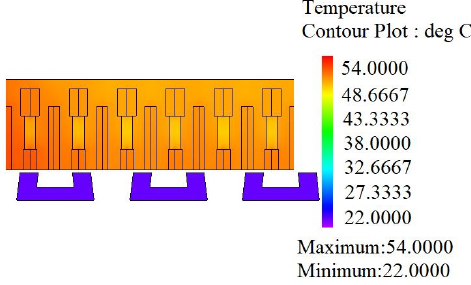
Figure 19. Temperature distribution. Table 7. Material Properties for thermal